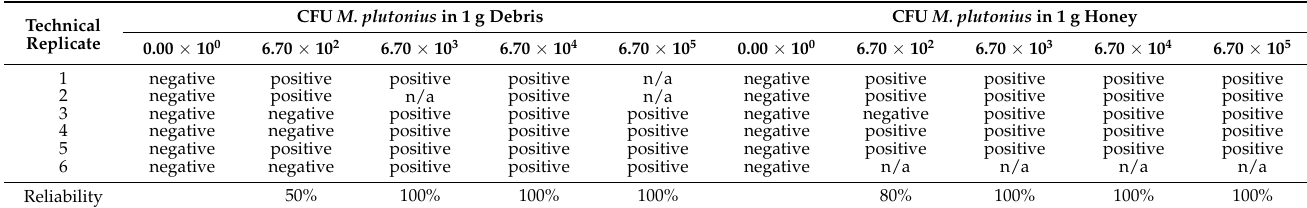
Table 1. Reliability of the analysis using Colony Forming Units (CFUs) of M. plutonius in spiked samples. Technical Replicate